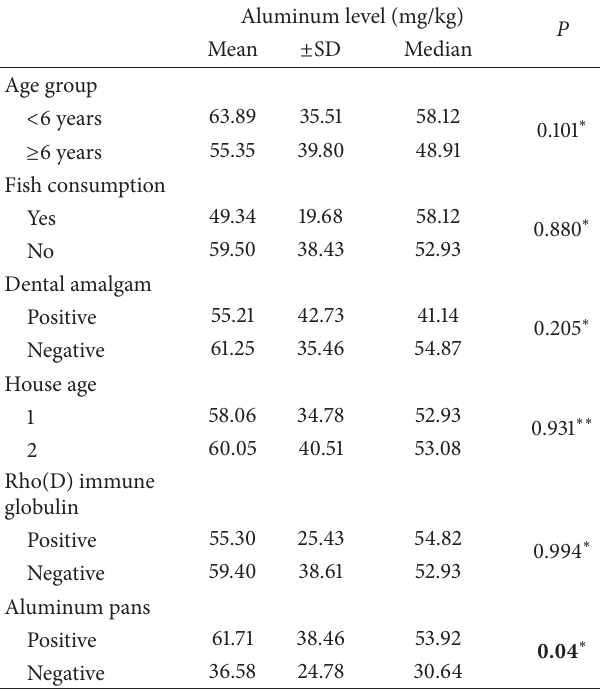
Table 6: Comparison between selected risk factors and aluminum hair levels among autistic